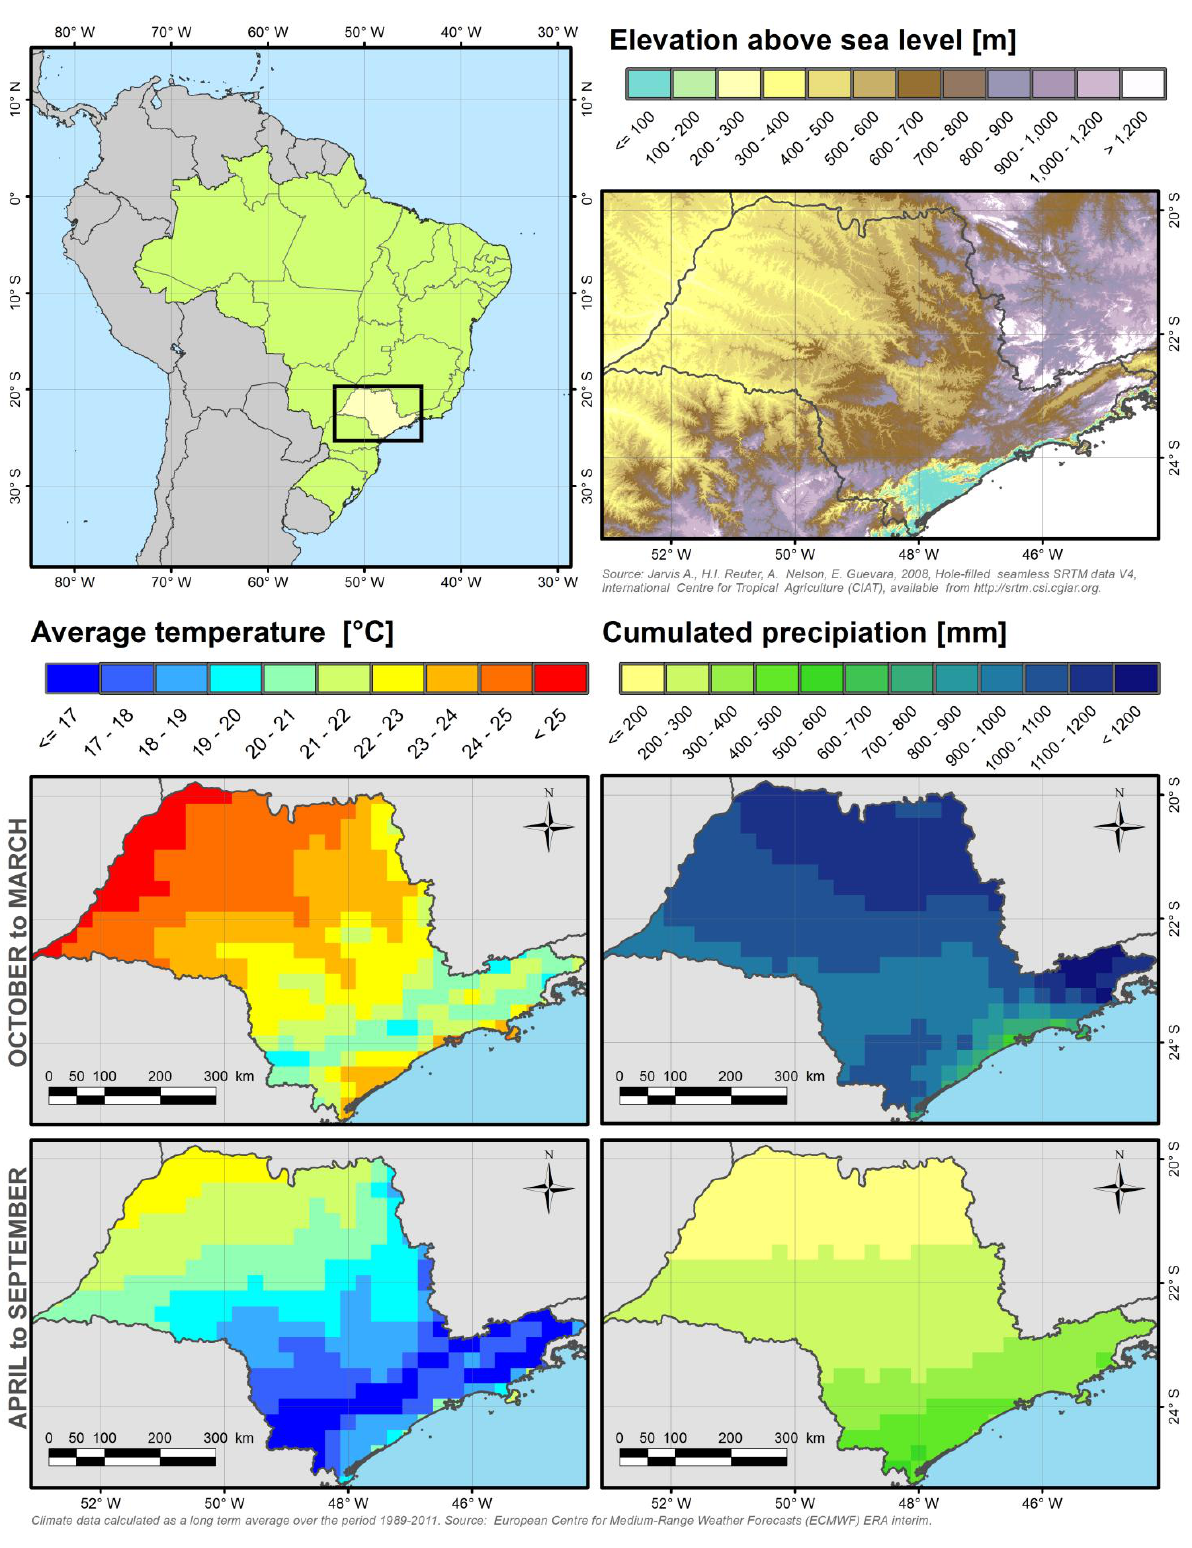
Figure 1. Geographical location, elevation and general climate of São Paulo